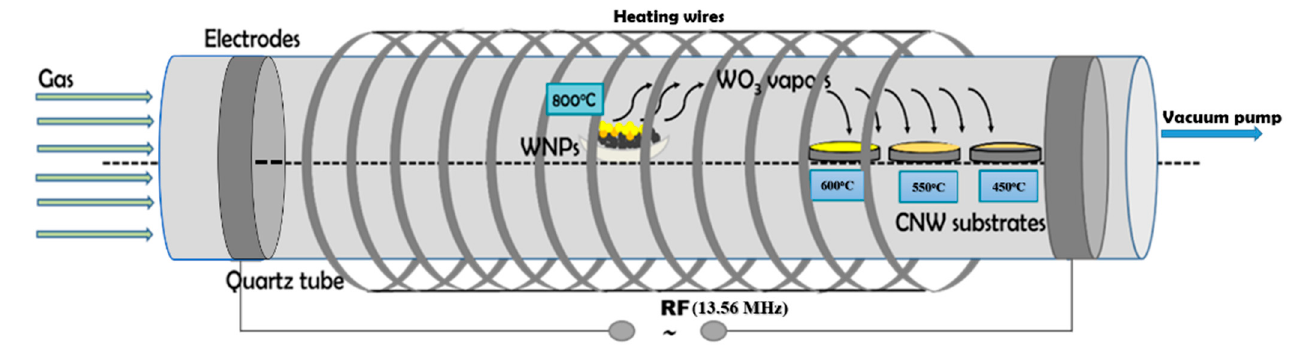
Figure 1. Schematic view of the experimental setup used for hybrid nanostructures synthesis in which the processes of heating which induced material sublimation, respectively thermal evaporation followed by condensation are highlighted.